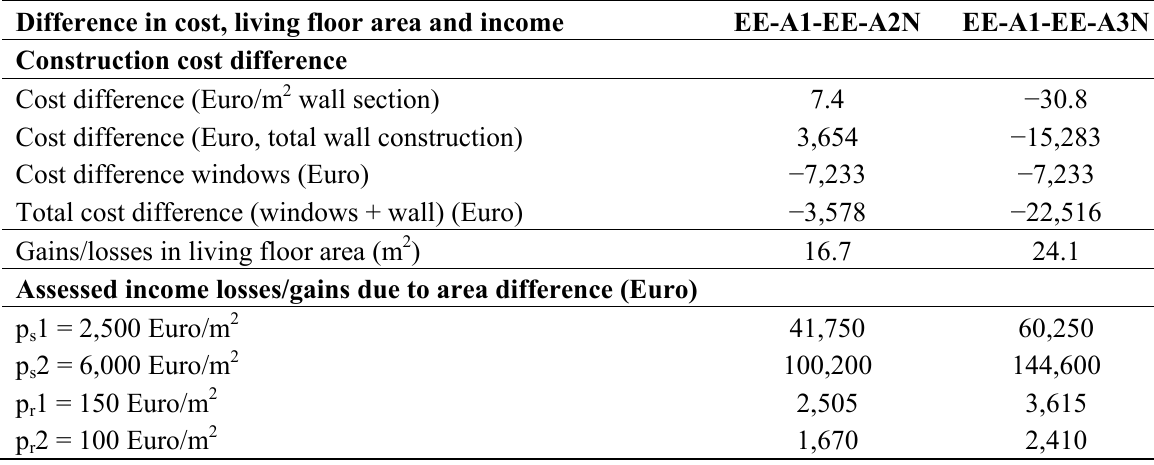
Table A4. Cost difference and assessed living area lost between energy-efficient and energy-efficient building constructed with new product, timber house.